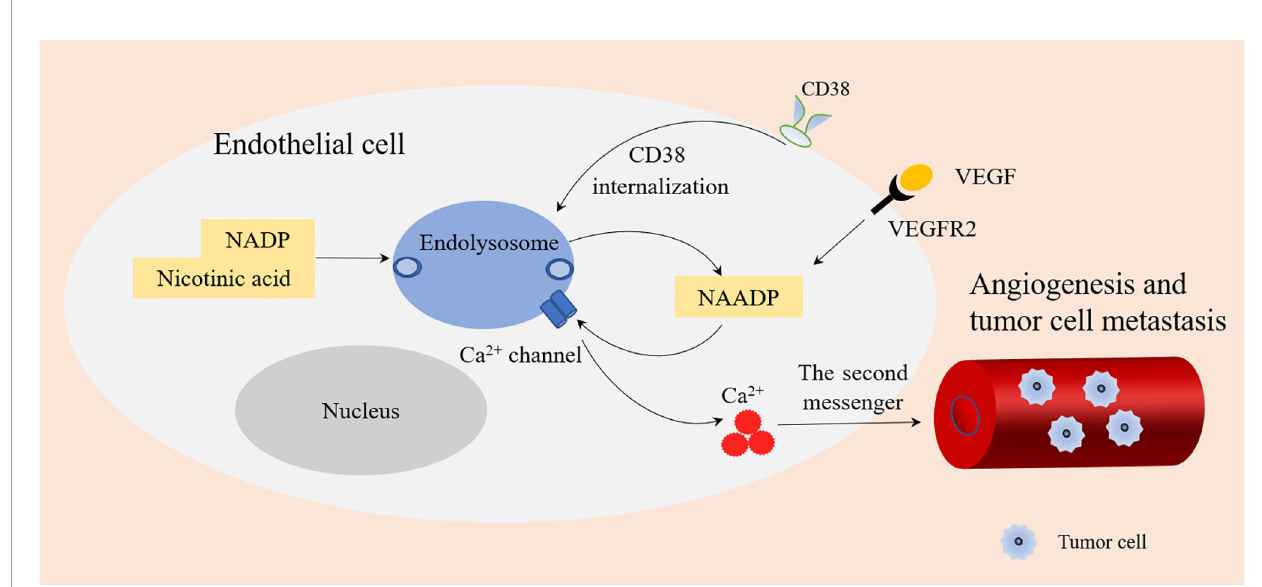
FIGURE 4 | NAADP produced by CD38 and angiogenesis. Type II CD38 is expressed on the cell surface and internalized into endolysosomes through endocytosis. Endolysosomes provide an acidic environment where NADP and nicotinic acid are transformed into NAADP by base exchange reaction. NAADP acts on Ca 2+ channels of Endolysosomes to promote the release of Ca 2+ (as a second messenger), which is conducive to angiogenesis and tumor cell metastasis. VEGF binds with its receptors VEGFR2 to stimulate the release of Ca 2+ by VEGFR2/NAADP/TPC2/Ca 2+ signaling pathway leading to